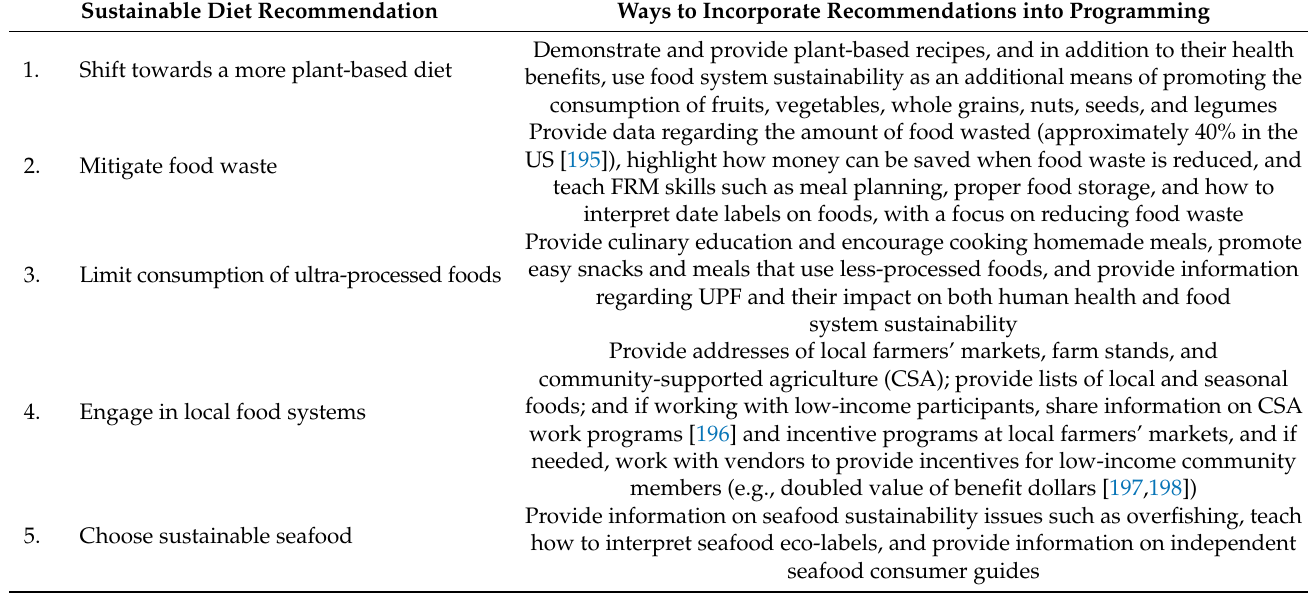
Table 2. Examples of how the 5 Sustainable Diet Recommendations can be incorporated into nutrition education programming. Sustainable Diet Recommendation Ways to Incorporate Recommendations into